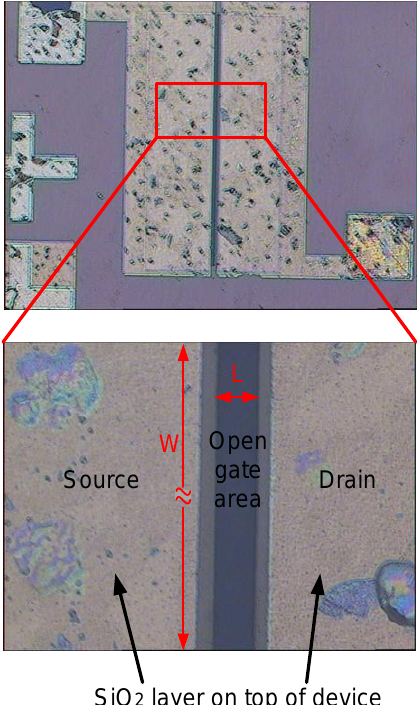
Figure 2. Photo of fabricated device (top